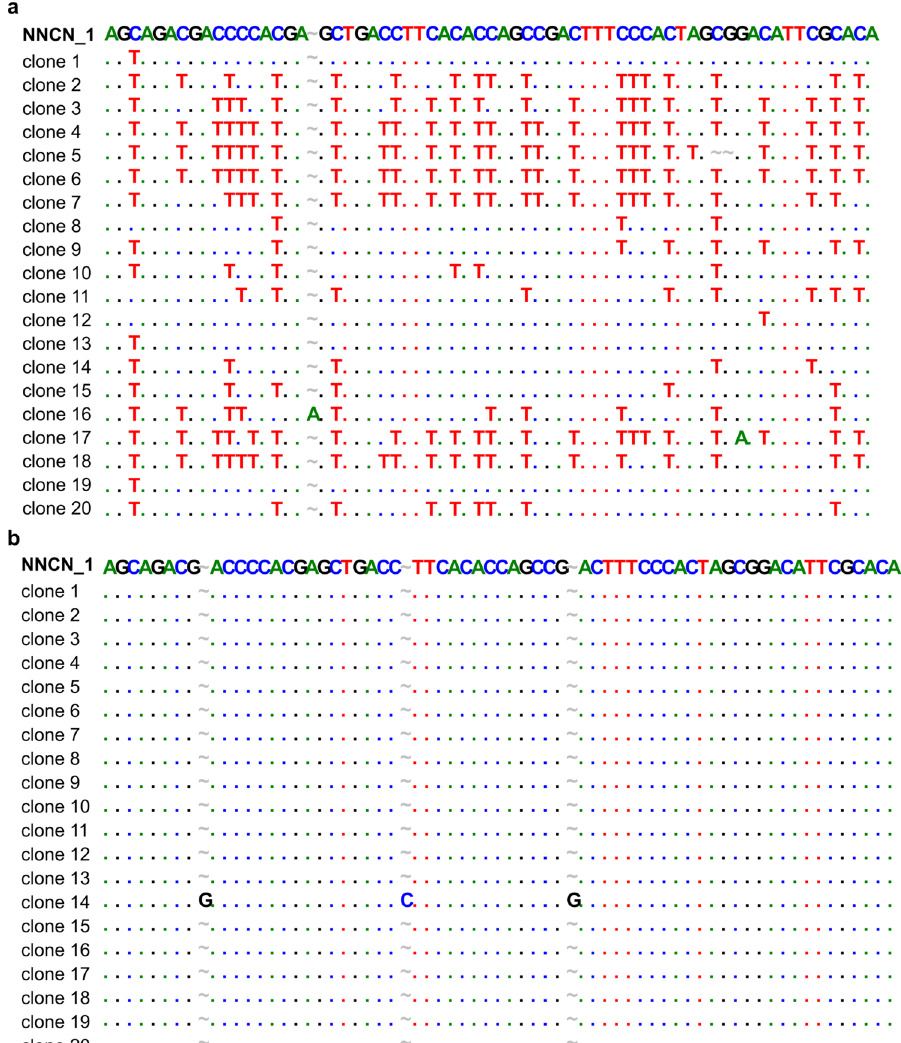
Figure 3. Representative results obtained during the analysis of wt hAID ( a ) or N51A mutant ( b ) deaminase activities on all possible combinations of NNCN sequences (20 clone sequences for NNCN_1 oligonucleotide; results for NNCN_2, 3, and 4 oligonucleotides are shown in Supplementary Fig. S3). The first line of each alignment contains the sequence of the NNCN_1 oligonucleotide untreated with hAID. Substitutions are indicated by one-letter symbols corresponding to a particular nucleotide. Positions identical to those in the untreated sequence are marked by dots. Deletions/insertions presumably caused by the used polymerase are marked by “~”. Flanking sequences – 20-nt-long PCR primer binding sites are not shown in the